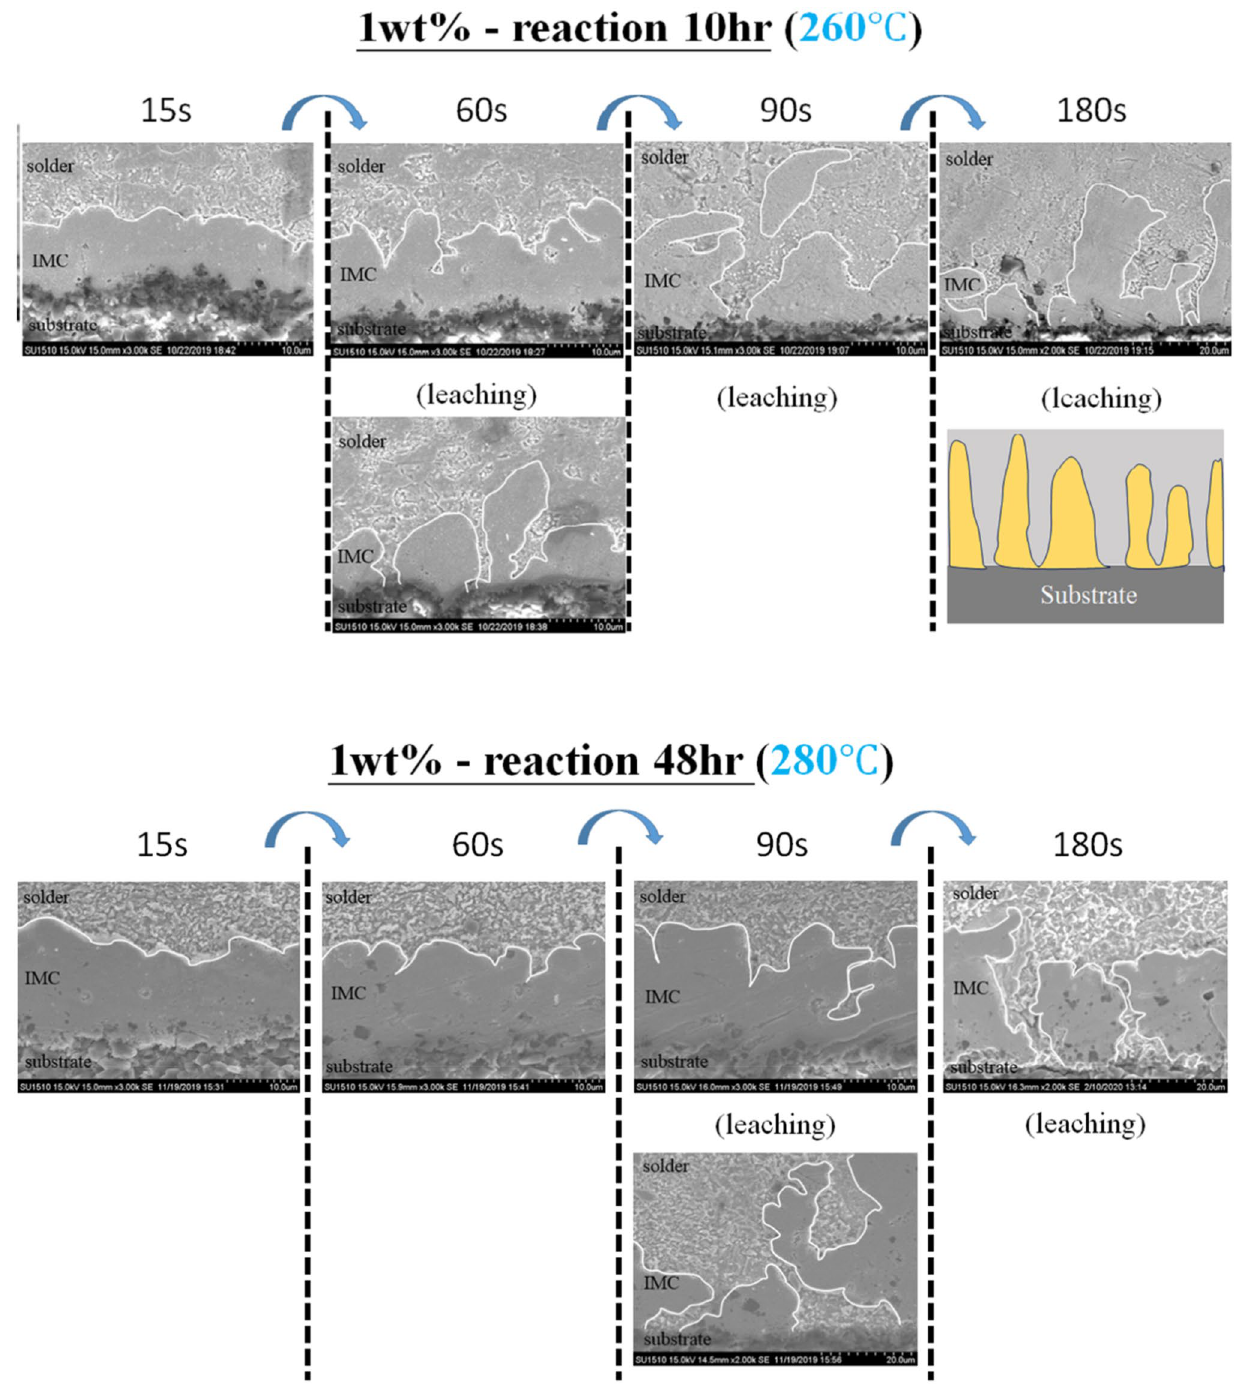
Fig. 5 Cross-sectional SEM images of interfaces after soldering at 260 °C and 280 °C for various times for silver pastes with 1 wt% TEOS at reaction times of 10 and 48